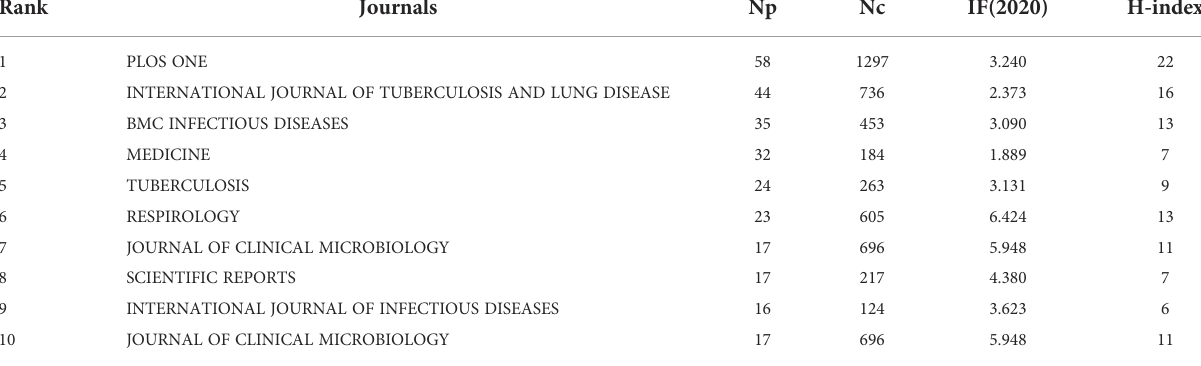
TABLE 4 The top 10 most active journals.